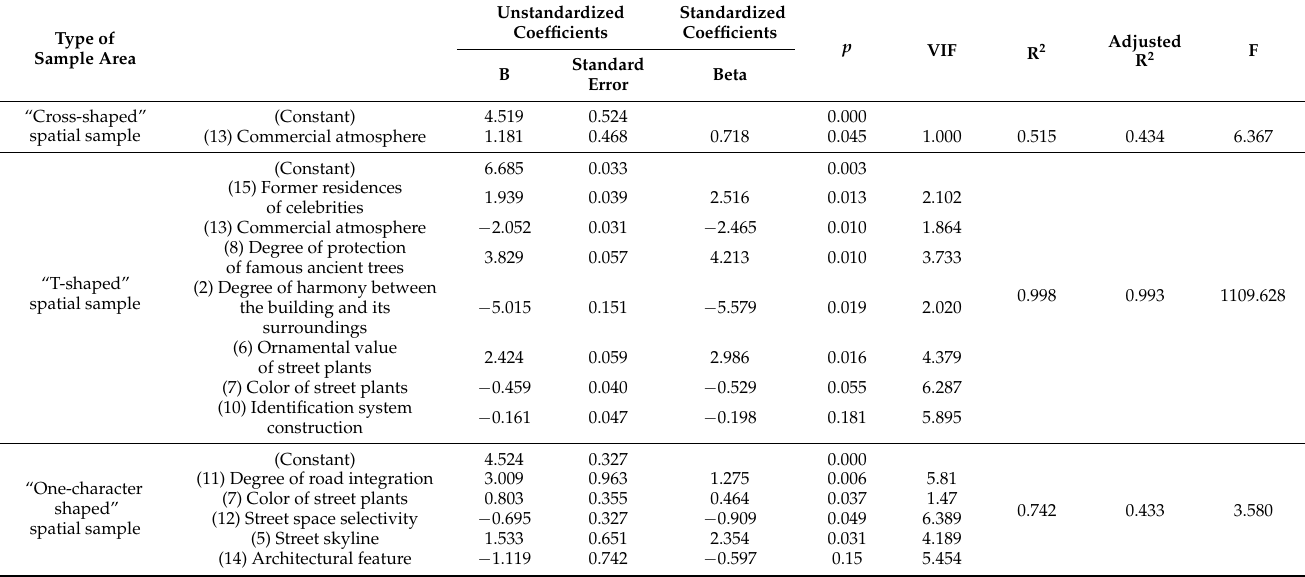
Table 5. Results of the multiple linear regression